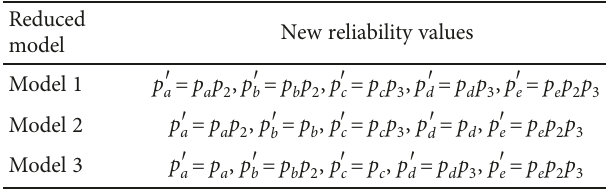
Table 2: Numerical results R